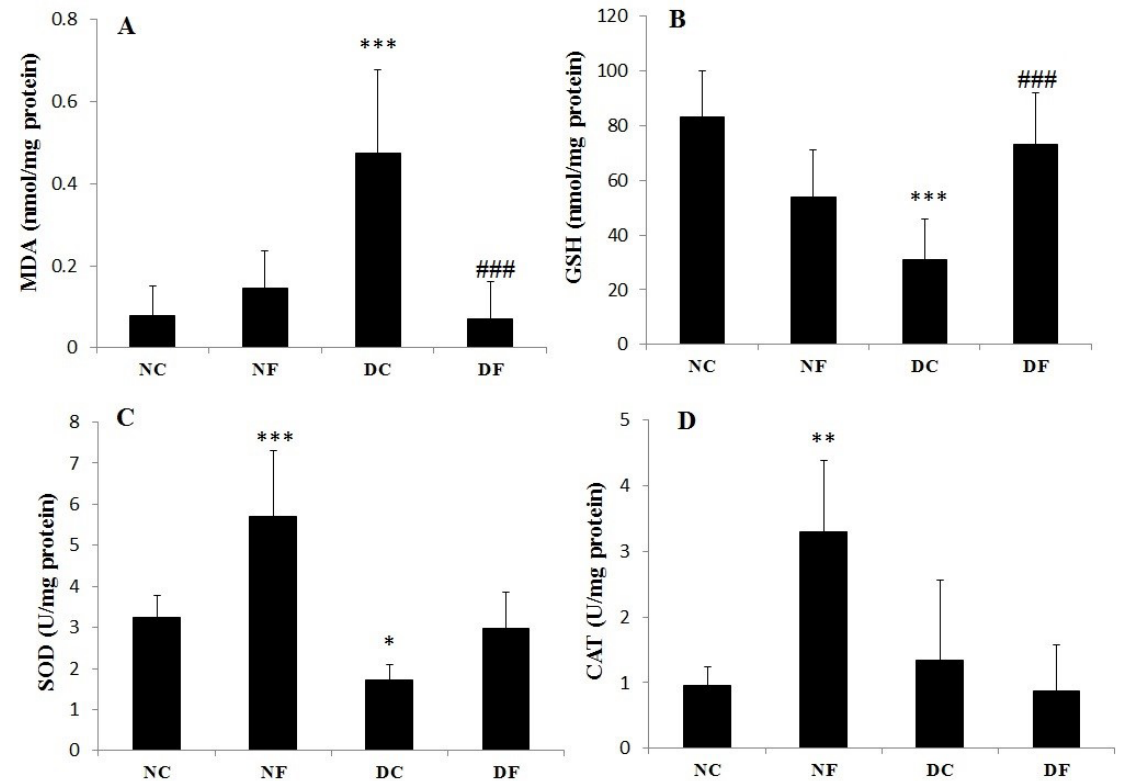
FIGURE 4 - Effects of fullerene on (A) MDA level, (B) GSH level, (C) SOD activity, and (D) CAT activity in the pancreas on day 60 after STZ injection. Differences in measured parameters among 4 groups analyzed by using One-way ANOVA, followed by the Tukey post hoc test. All the data were presented as mean ± standard deviation of the mean. The symbol * and # denote significant differences with the normal and diabetic groups, respectively; *P<0.05, **P<0.01, ***P=0.001, and ### P=0.001. NC; normal control, NF; normal+fullerene, DC; diabetic control, DF;